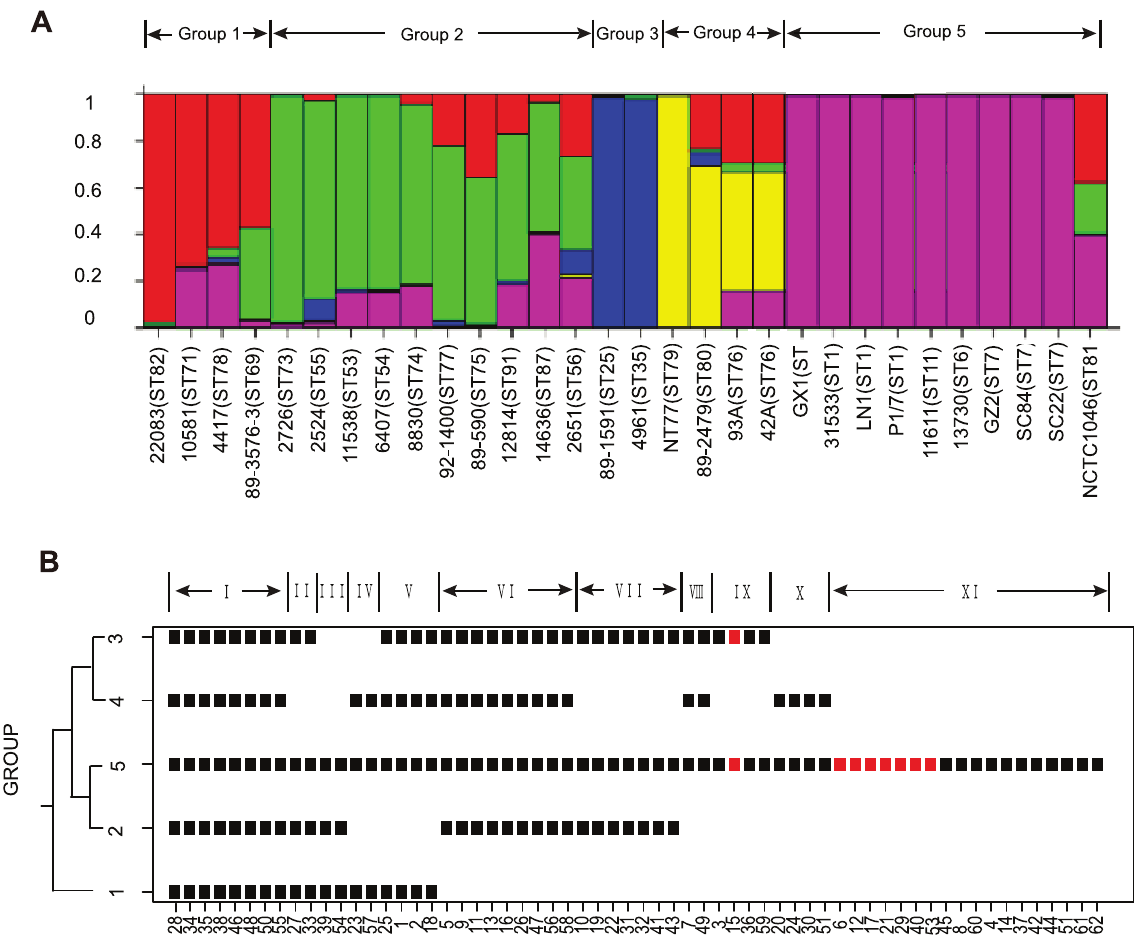
Figure 6. Population structure and distribution of regions of difference (RDs) among subpopulations. (A) Division of the 31 strains into subpopulations (groups) based on STRUCTURE analysis of multilocus sequence typing data. The 5 subpopulations (groups) are colour coded. Group numbering and strain details are shown above and below the population strip respectively. Each isolate has been allocated to a subpopulation. Imports from another subpopulation are shown in its respective subpopulation colour. Y-axis is the proportion of subpopulation allocation for a strain. (B) Distribution of RDs among the subpopulations (groups). On the left is a phylogeny of the 5 groups, based on neighbour joining tree of representative strains without imports from each group shown in (A). On the right is the plot of the distribution of RDs. The distribution was grouped into 11 patterns as shown at the top. Each square represents a RD present in greater than 75% of the strains in that group. Squares marked red were RDs associated with high pathogenicity strains as identified by cluster and statistical